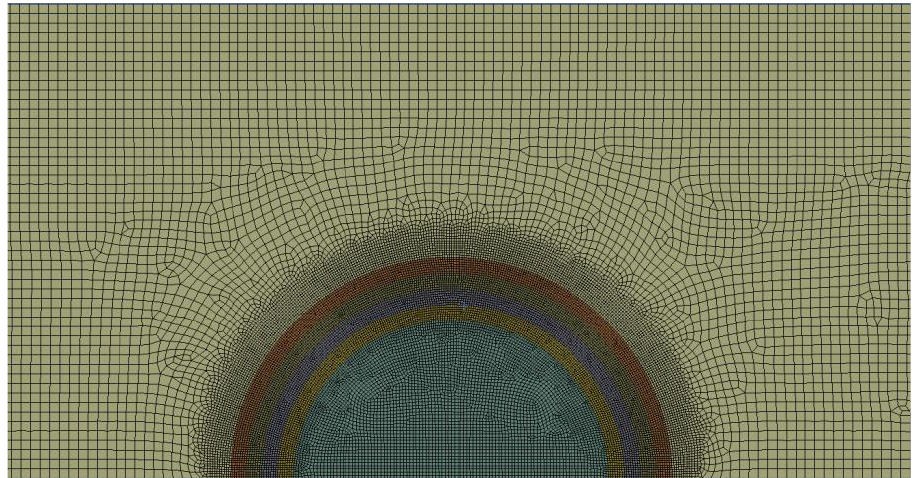
Figure 2. Computational mesh of the simulation domain. The mesh is refined in the interfacial fluid-solid region and each shell consists of at least 6 cells in radial direction.